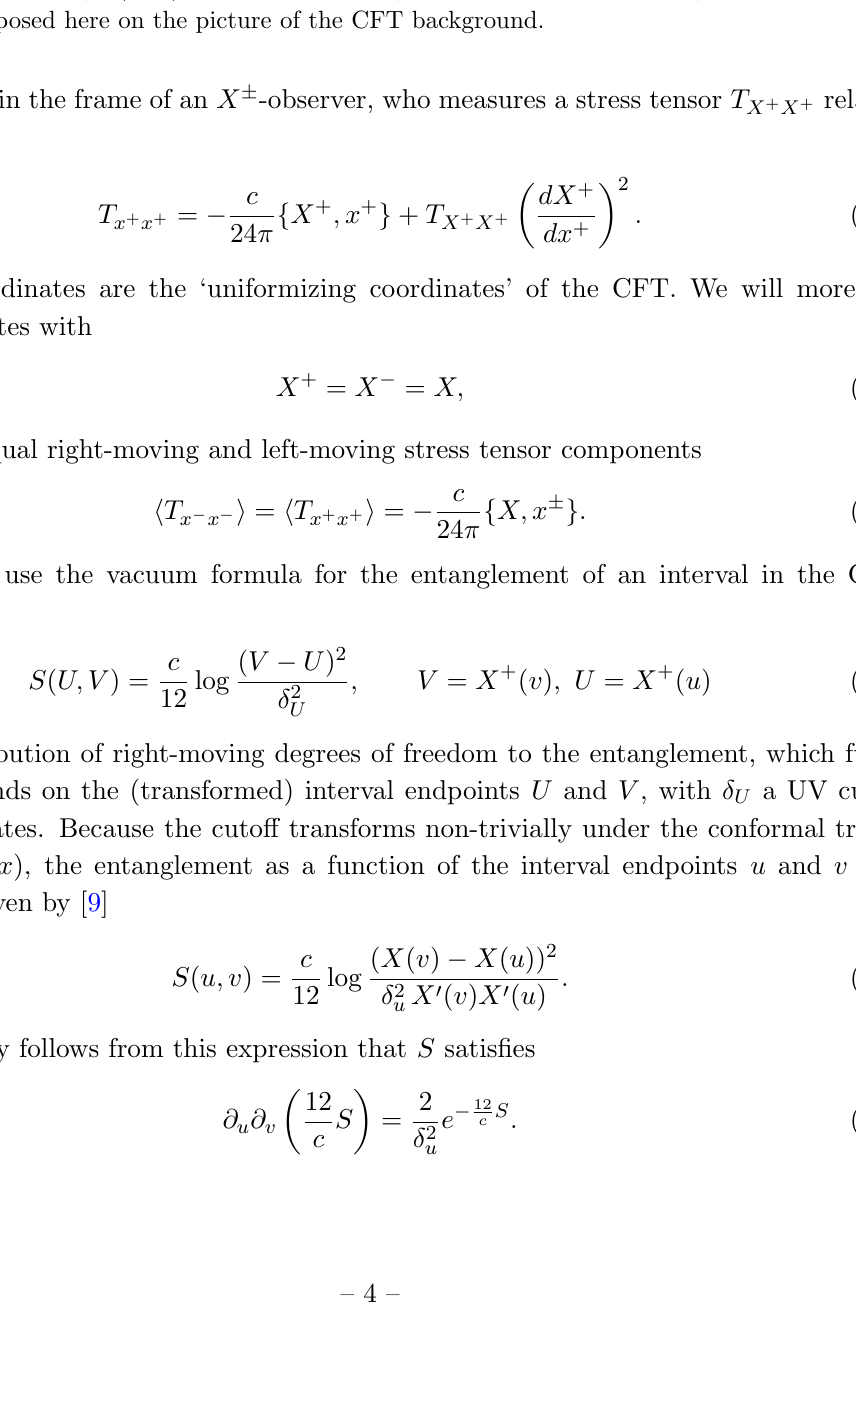
Figure 1 . Interval x [ u; v ] (in blue) on a constant time slice of a CFT 2 in vacuum state 2 kinematic space construction involves 1) promoting the t = 0 time-slice of the CFT to past in(cid:12)nity of kinematic space, 2) identifying the interval endpoints u and v with kinematic space lightcone coordinates, and 3) using the one-interval entanglement formula to de(cid:12)ne a hyperbolic metric on kinematic space through (2.13). The yellow triangle is a sketch of the emergent dS 2 kinematic space, superimposed here on the picture of the CFT